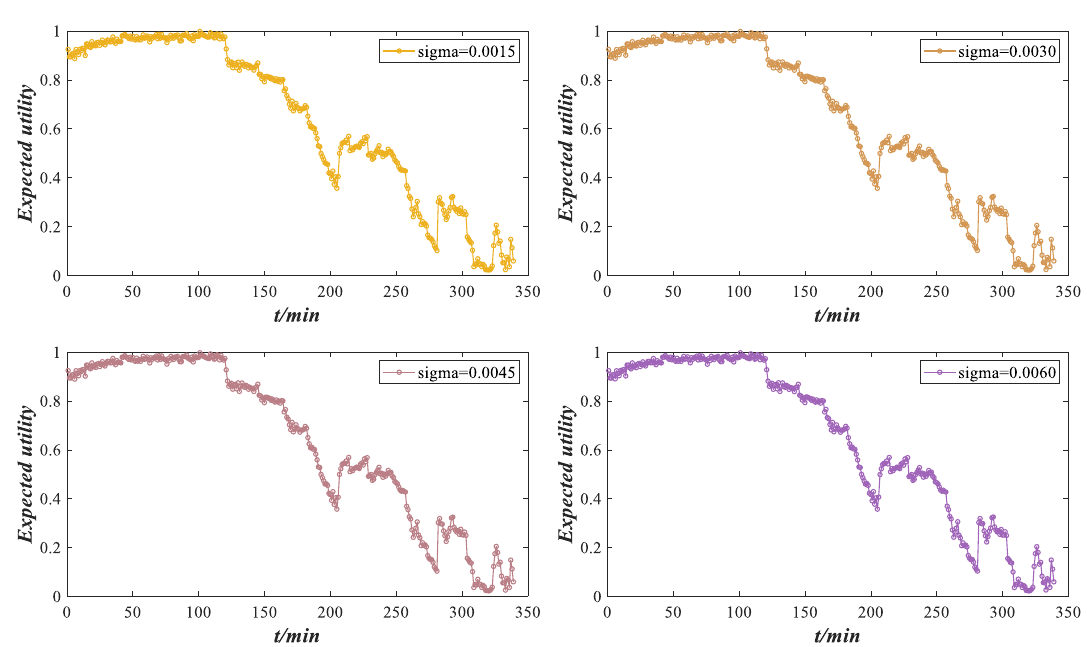
Figure 31. Expected utility of XJTU-SY bearing performance under different perturbation